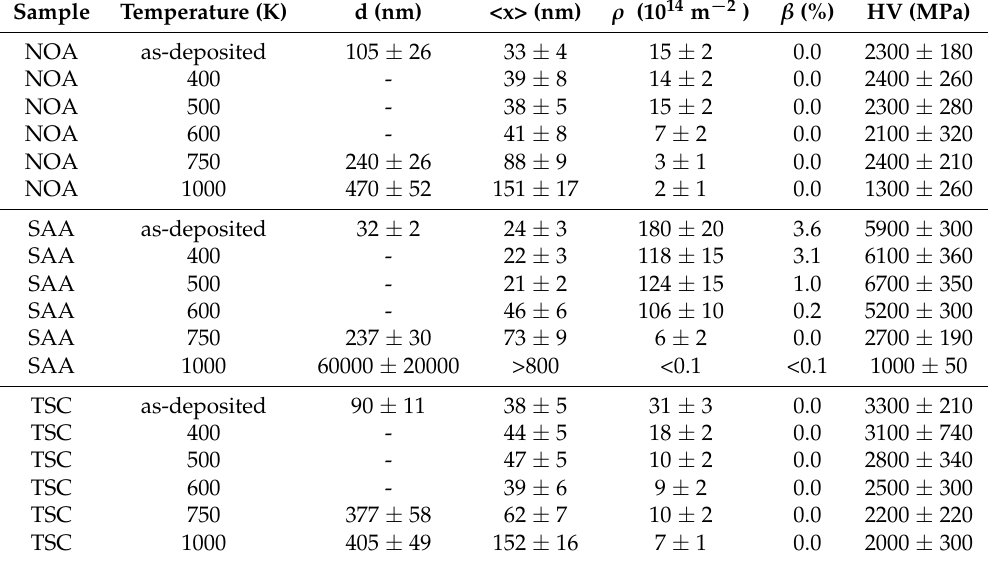
Table 2. The grain size determined by transmission electron microscopy (TEM) (d), the crystallite size (<x>), the dislocation density ( ρ ) and the twin fault probability ( β ) obtained by XLPA and the hardness for the as-deposited and the heat treated samples. It is noted that for all layers heated up to 1000 K the grain size was determined by EBSD.